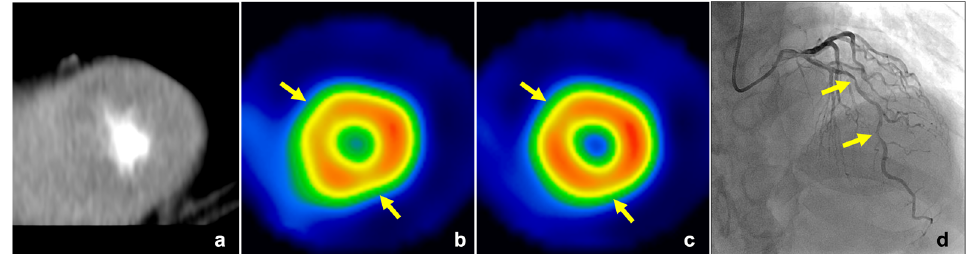
Figure 5. A 64-year-old man with effort angina. No obvious low-attenuation area was observed in the stress CTP image for the visual assessment ( a ), but the perfusion abnormalities were detected with MPR in the anterior and inferior myocardium of the apex (MPR: 0.69 and 0.71 < cut-off value: 0.81, respectively). SPECT (( b ), stress; ( c ), rest) showed reversible perfusion abnormalities in the anterior and inferior myocardium in the apex (yellow arrow). ICA revealed tandem lesions with moderate and severe stenosis in the LAD (yellow arrow, ( d )). The FFR of LAD was 0.68. CTP, computed tomography perfusion; MPR, myocardial perfusion ratio; SPECT, single-photon emission computed tomography; ICA, invasive coronary angiography; LAD, left anterior descending artery; FFR, fractional flow reserve.